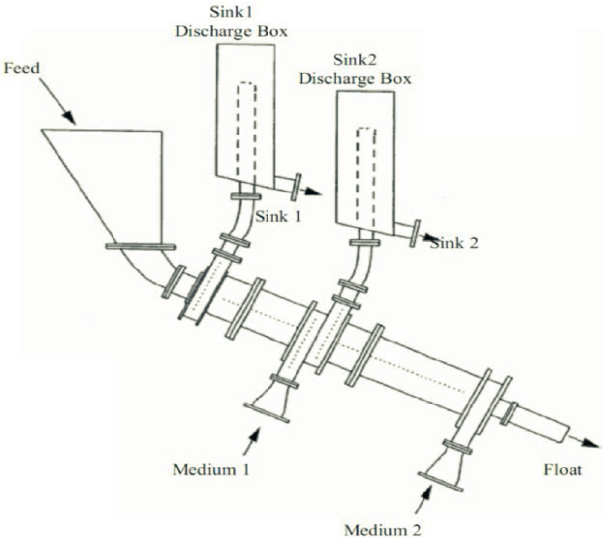
Fig. 3. Schematic diagram of a tri-flo separator [13].